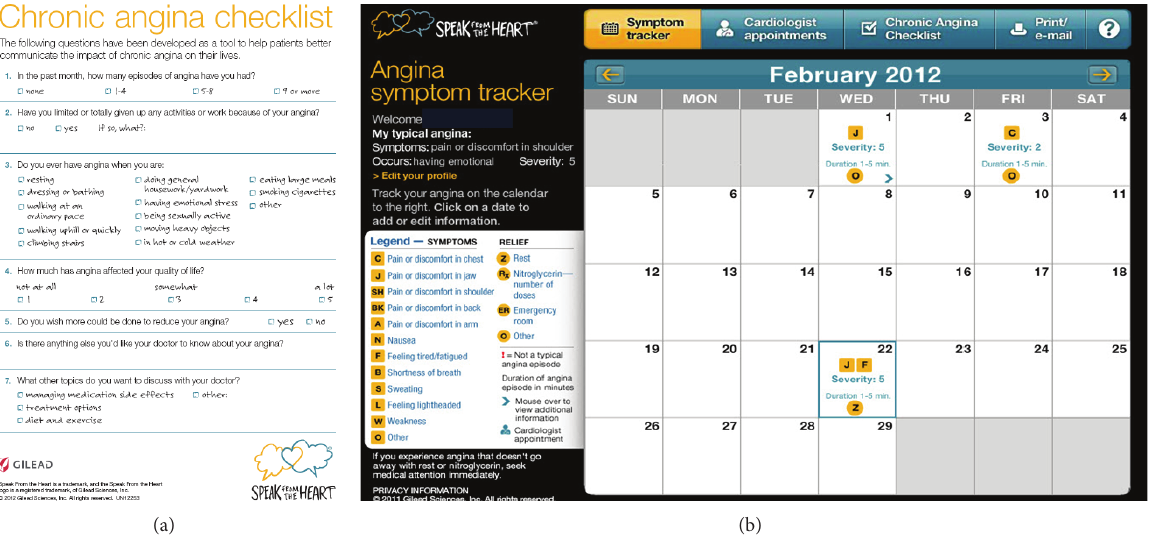
Figure 1: The Speak from the Heart chronic angina checklist and symptom tracker. Available at http://www.speakfromtheheart.com/ (for patients) [27] or at http://www.helpthemspeak.com/ (for healthcare